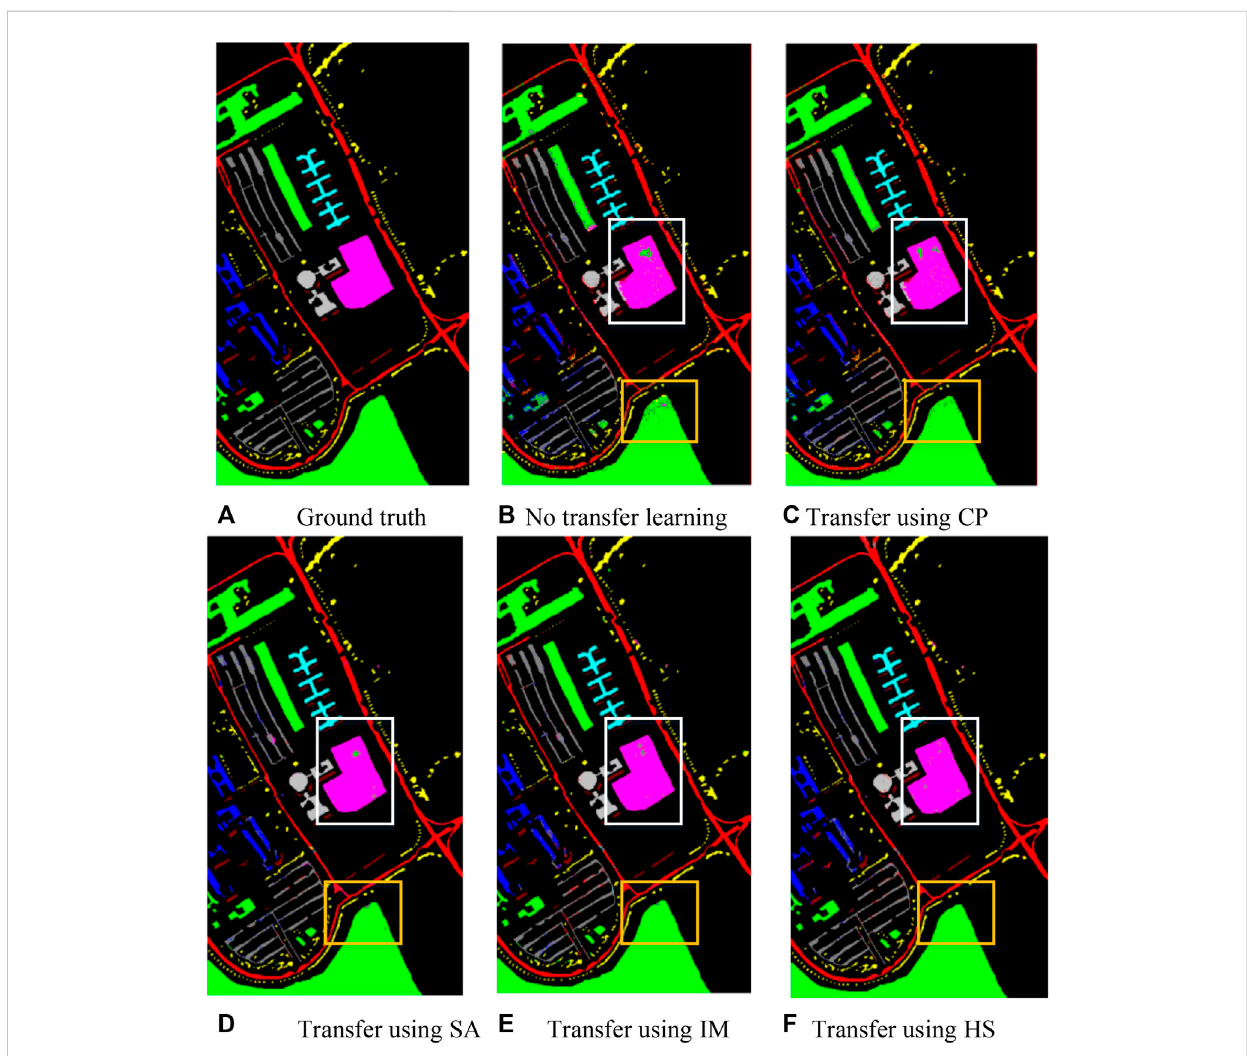
FIGURE 4 Classi fi cation visualization result diagram using different transfer datasets. (A) Ground truth; (B) No transfer learning; (C) Transfer using CP; (D) Transfer using SA; (E) Transfer using IM; (F) Transfer using